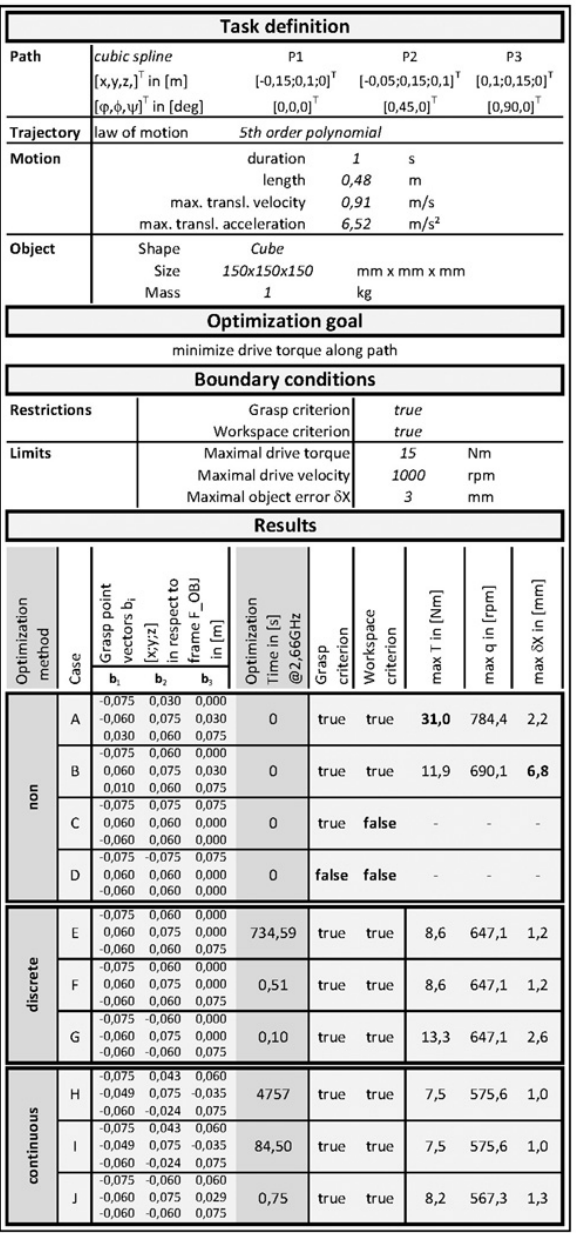
Table 1. Results of an optimization